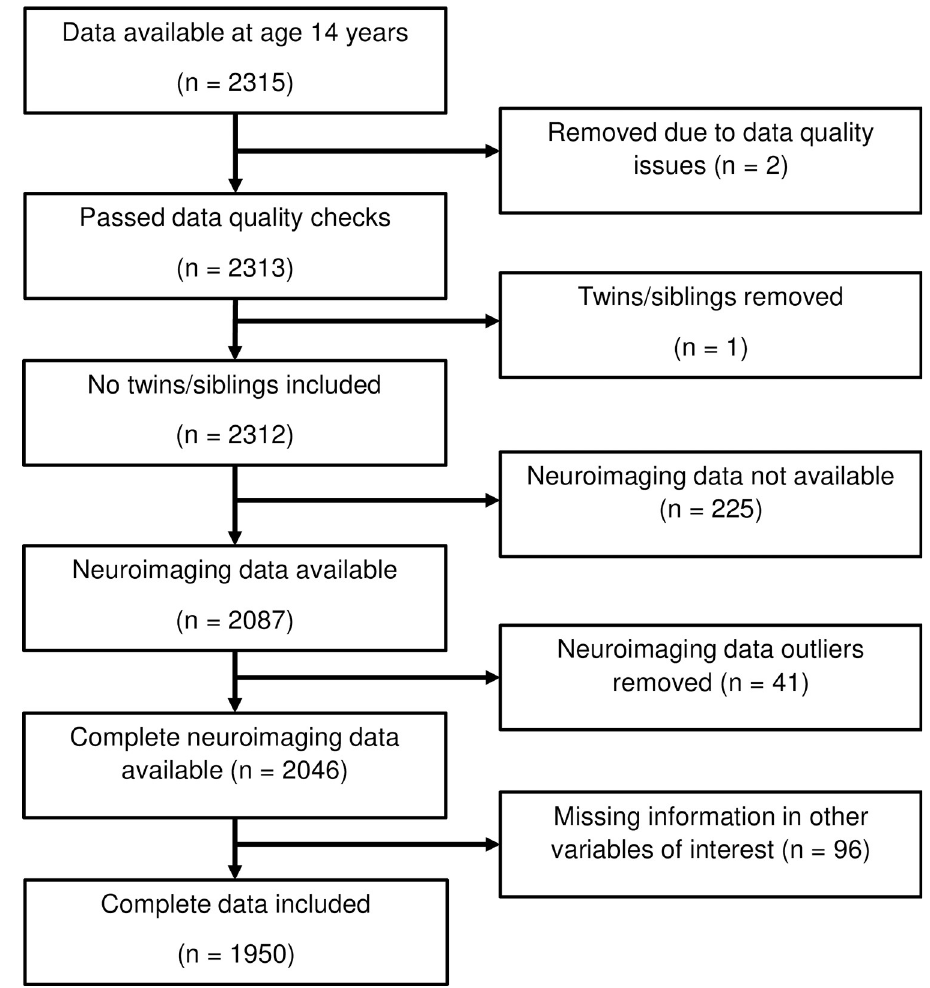
Fig 1. Flow chart showing the derivation of the sample used for the